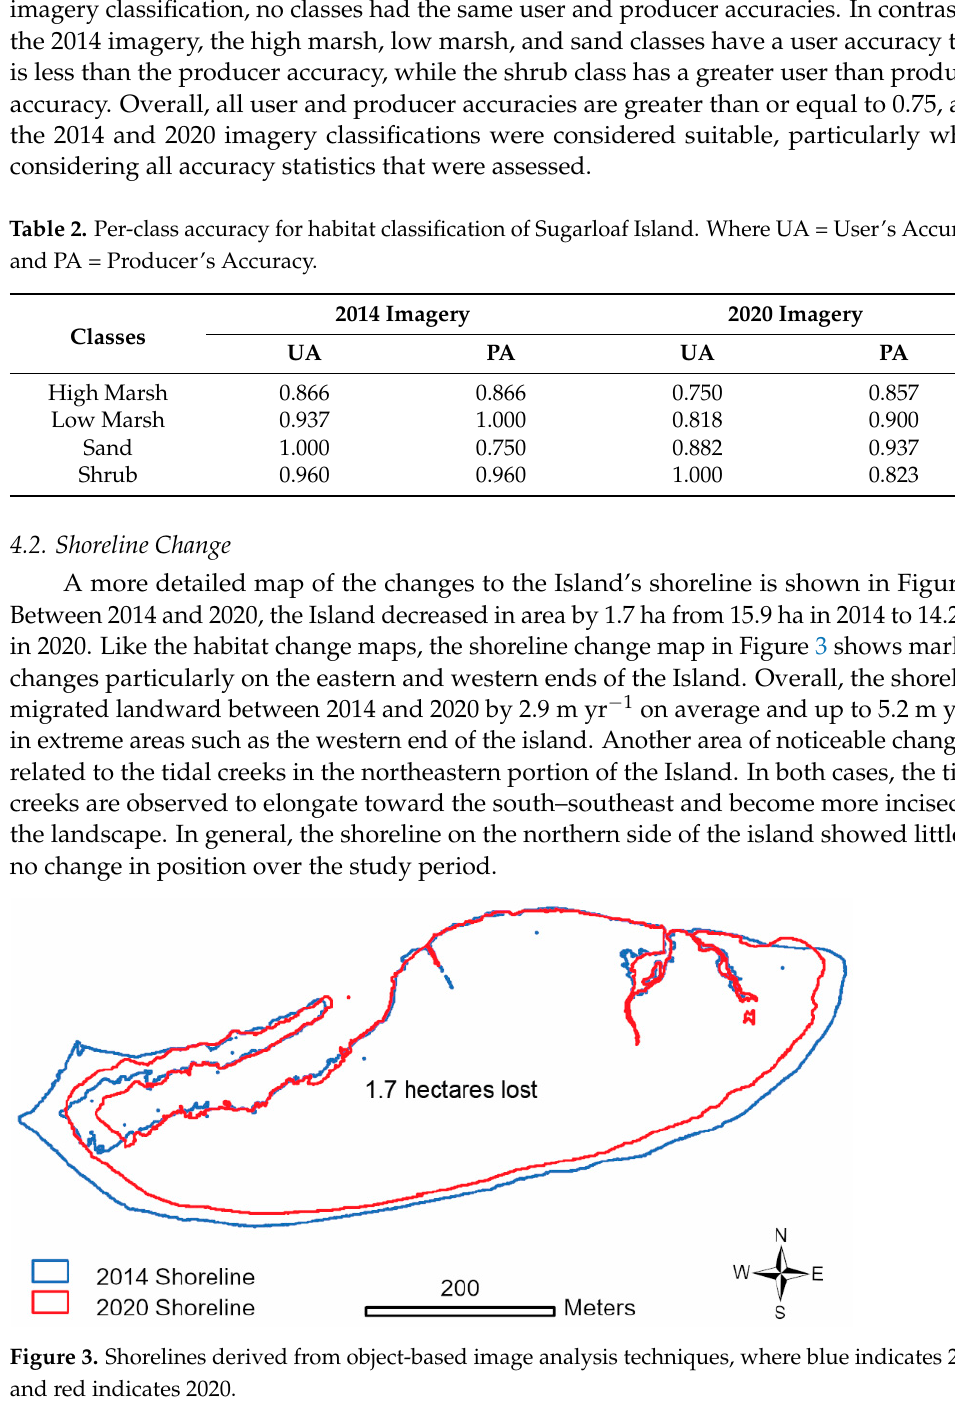
and red indicates 2020.